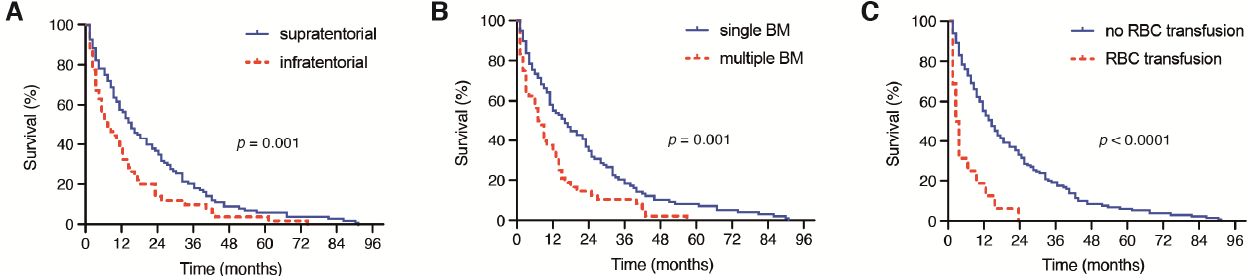
Figure 2. Kaplan–Meier survival curves depicting the influence of ( A ) the presence of a supratentorial or infratentorial localization of BM, ( B ) single versus multiple BM and ( C ) the presence of perioperative RBC on the OS in patients with BM derived from NSCLC. BM: brain metastases; NSCLC: non-small cell lung cancer; RBC: red blood cell; OS: overall survival.